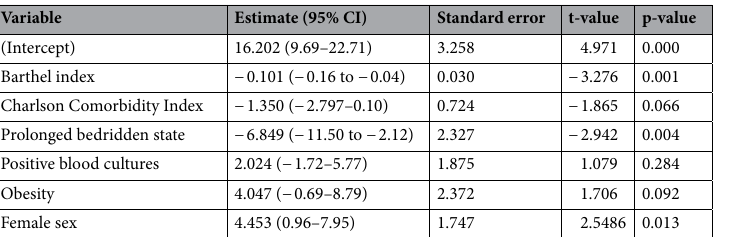
Table 5. Linear regression model of risk factors for long hospital stay in the subgroup of patients with positive urine tract infection.